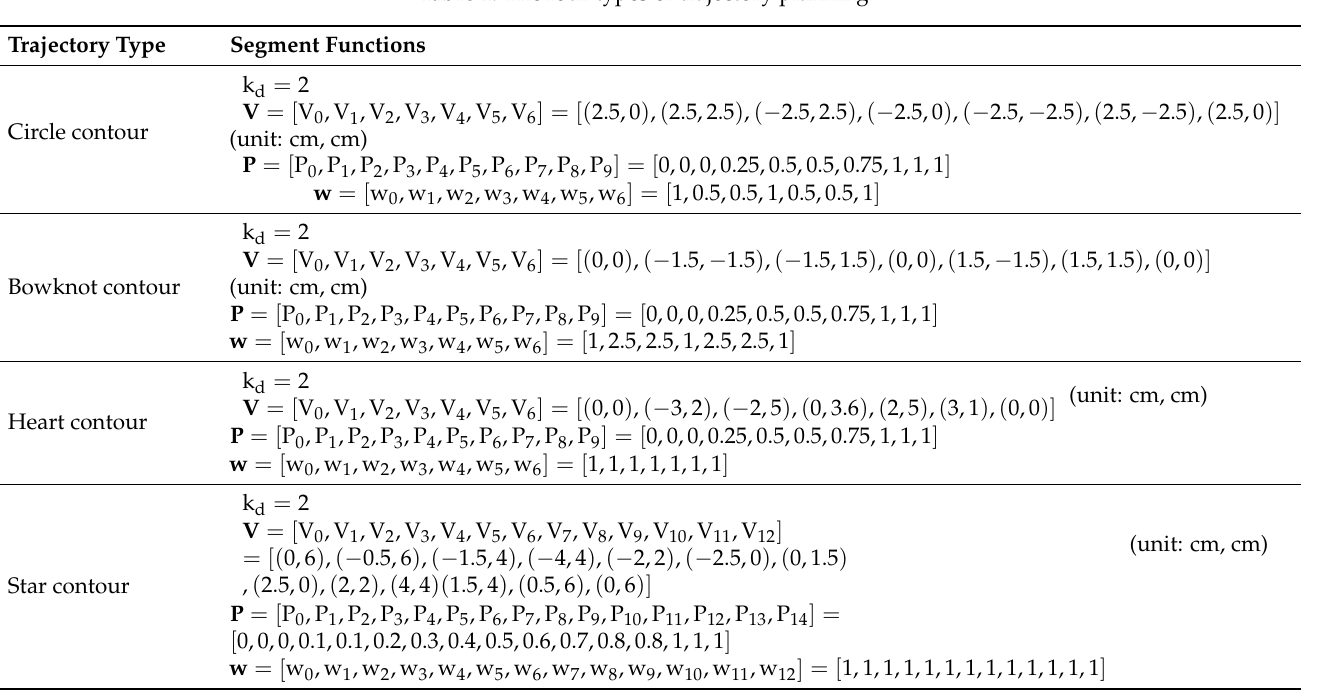
Table 1. The four types of trajectory